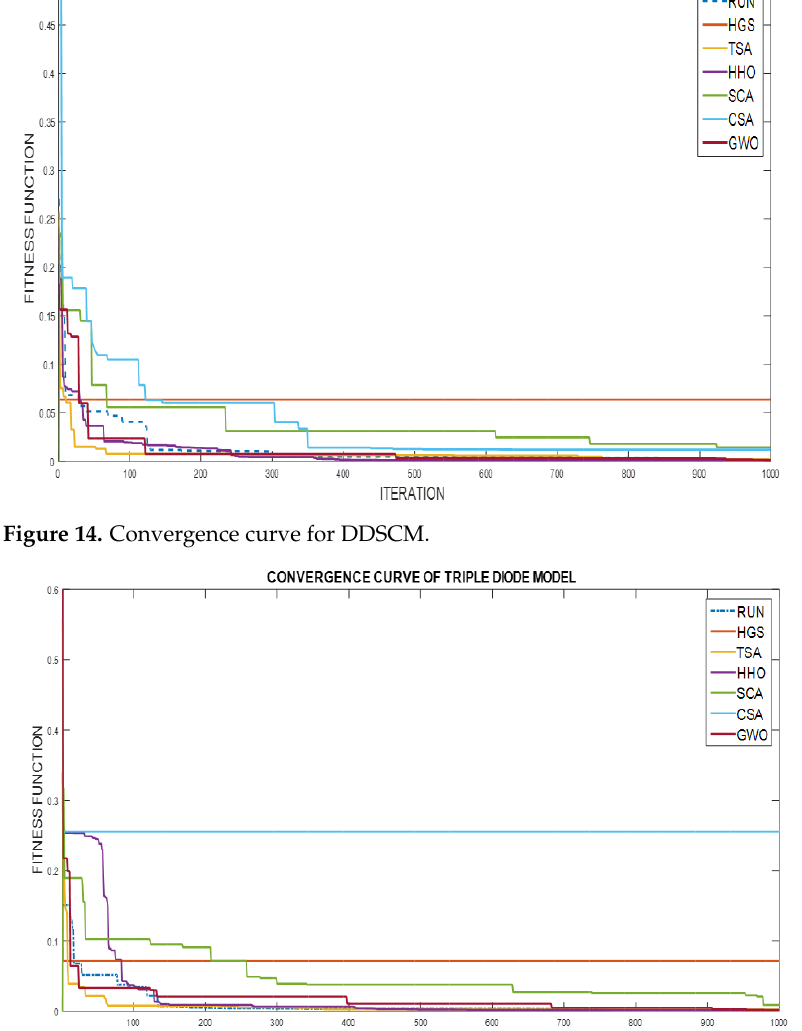
Figure 15. Convergence curve for